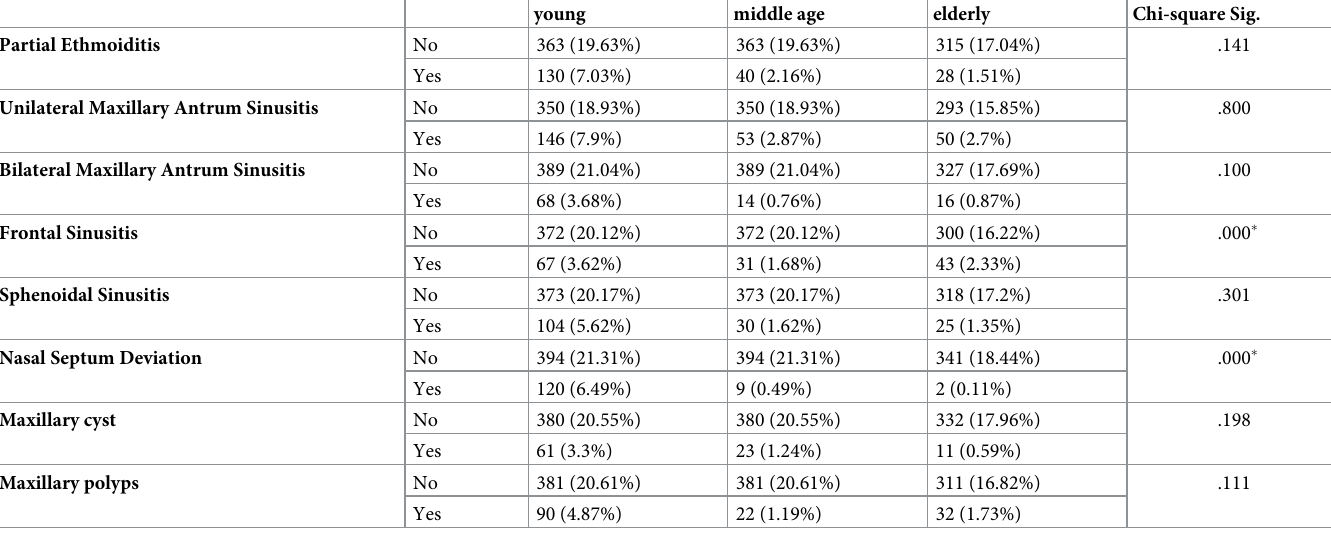
Table 3. Shows the association between the age group and the types of paranasal sinusitis. It represents the frequency (%), and yes/no indicates the presence/absence of the abnormality. young middle age elderly Chi-square